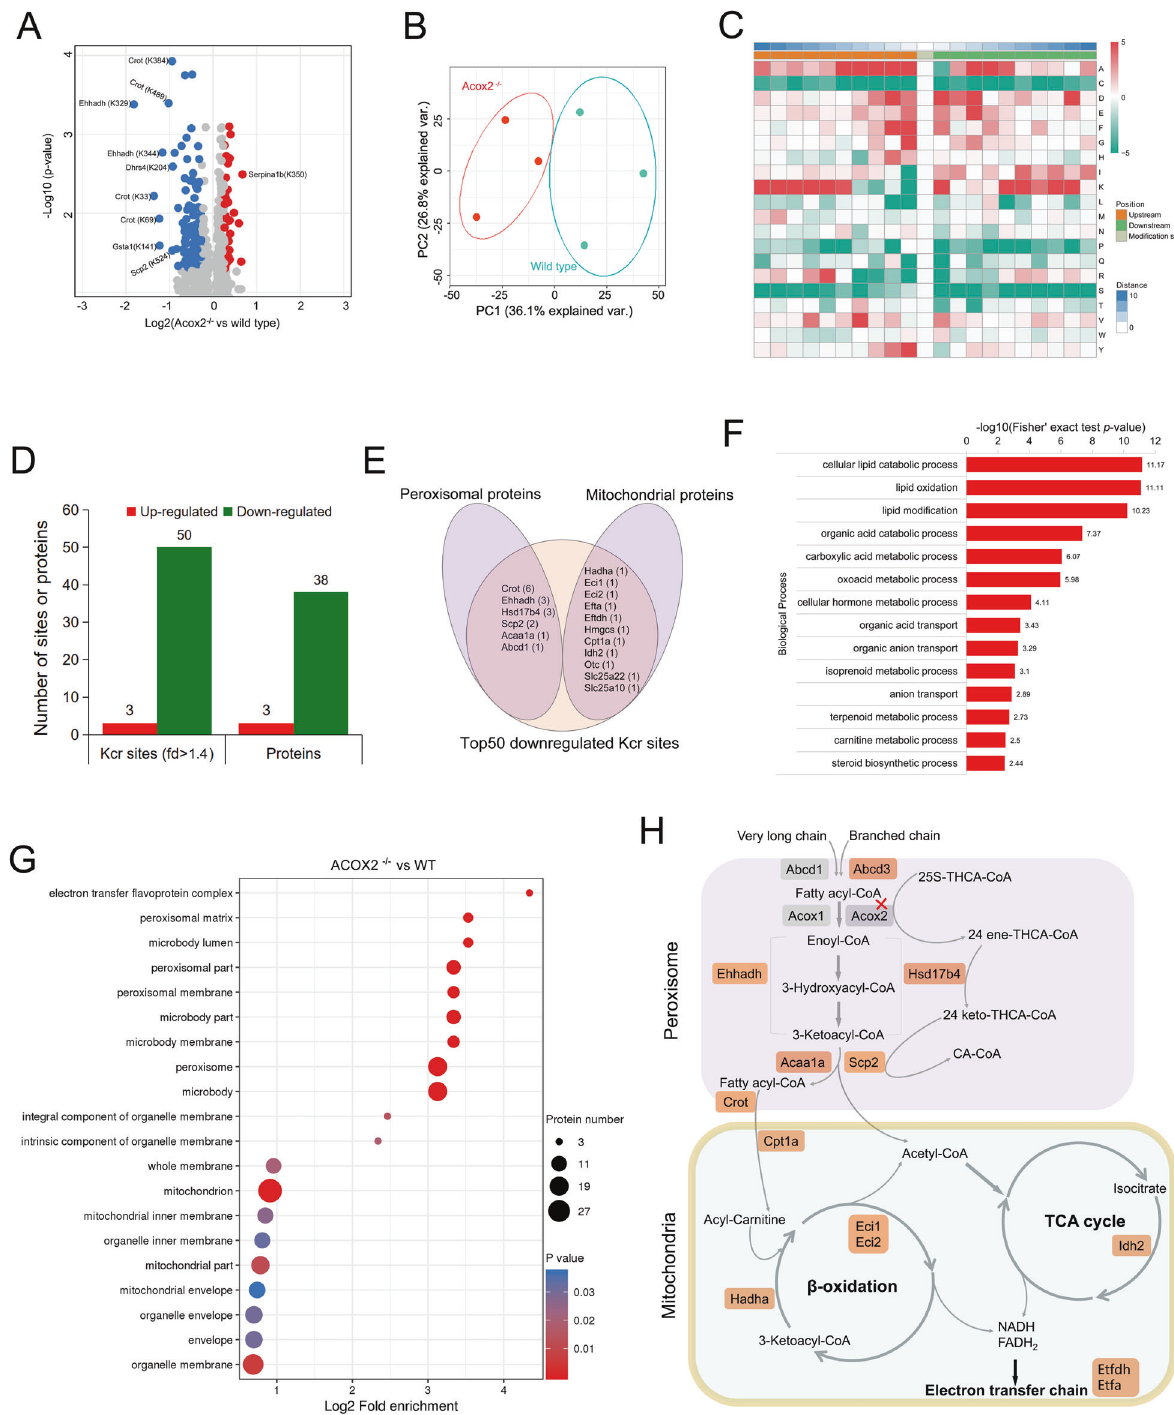
Fig. 5 Global crotonylome analysis of liver tissues in Acox2 − / − and WT mice. A Volcano plots showing the signi fi cantly changed Kcr sites (FDR < 1%, p < 0.05). Up- and downregulated Kcr sites are highlighted in red and blue, respectively. B Score plots of principal component analysis (PCA) of Acox2 − / − and WT crotonylome. C Motif analysis of all identi fi ed crotonylated sites. D Compared with the wild type (WT) group, 50 downregulated Kcr sites on 38 proteins and 3 upregulated Kcr sites on 3 proteins were identi fi ed in Acox2 − / − mice (fold-change >1.4; FDR < 1%; p < 0.05). E Venn diagram showing 32% (16/50) and 22% (11/50) of downregulated Kcr sites were located in the proteins involved in peroxisomal and mitochondrial metabolism, respectively. F , G Analysis of Biological Process ( F ) and Cellular Component ( G ) of downregulated Kcr proteins by Gene Ontology (GO) enrichment (Fisher ’ s exact test; p < 0.05). Top selected pathways are shown in each category as indicated. H Schematic representation of downregulated hepatic Kcr on enzymes involved in fatty acid oxidation and TCA cycle in Acox2 − / − mice. Proteins carrying downregulated Kcr sites are marked in brown.